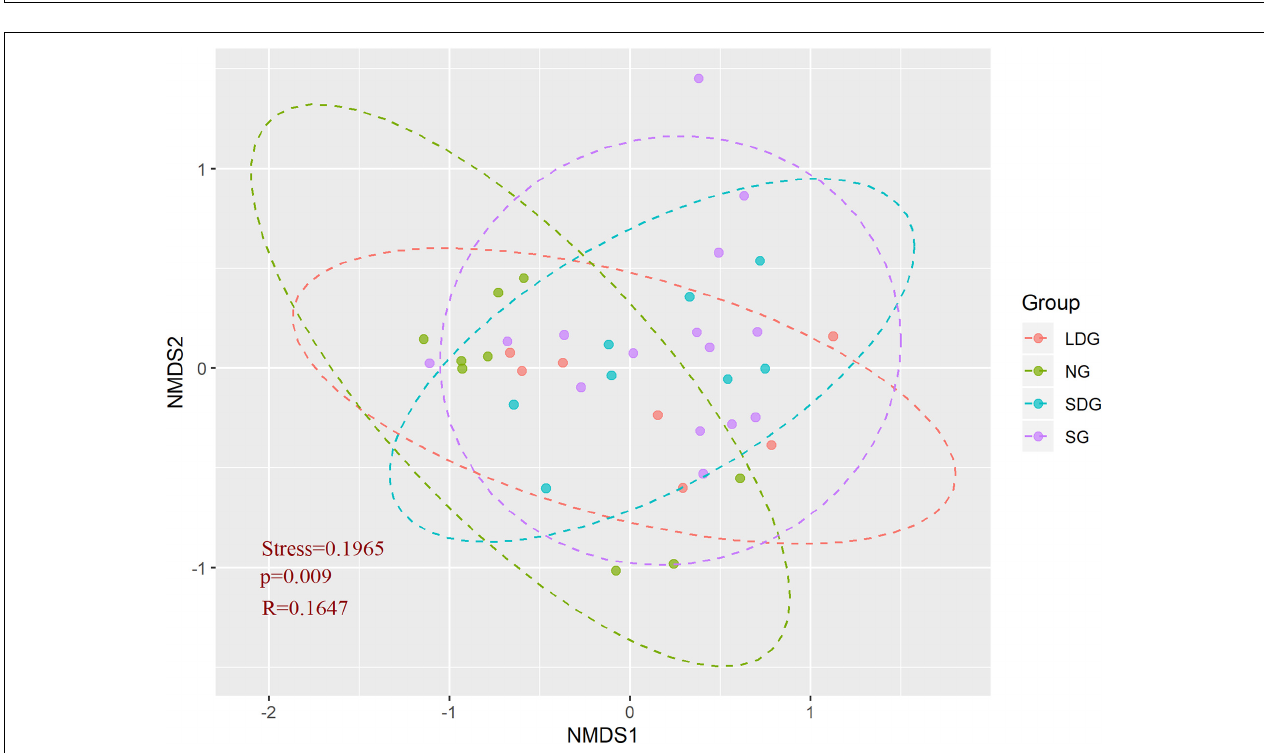
FIGURE 5 | Relative abundance clustering heat map of asymbiotic nitrogen-fixing bacteria. Horizontal axis: Sample names, Group refers to different types of grassland, vertical axis: asymbiotic nitrogen-fixing genus, each belonging to a different Phylum. NG (orange), natural grassland; SG (brown), sown grassland; LDG (gray), lightly degraded grassland; SDG (blank), severely degraded grassland.